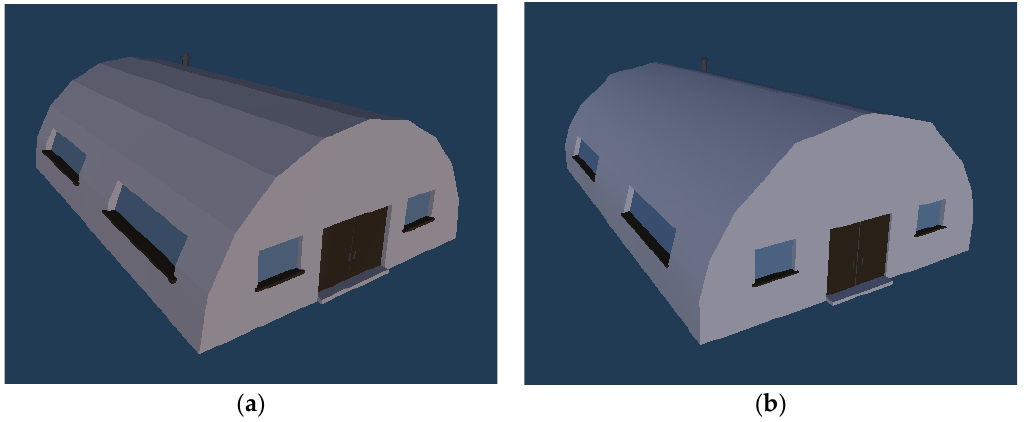
Figure 5. ( a ) Barrack model from the improved version of the game. ( b ) Barrack model from the non-improved version of the game.